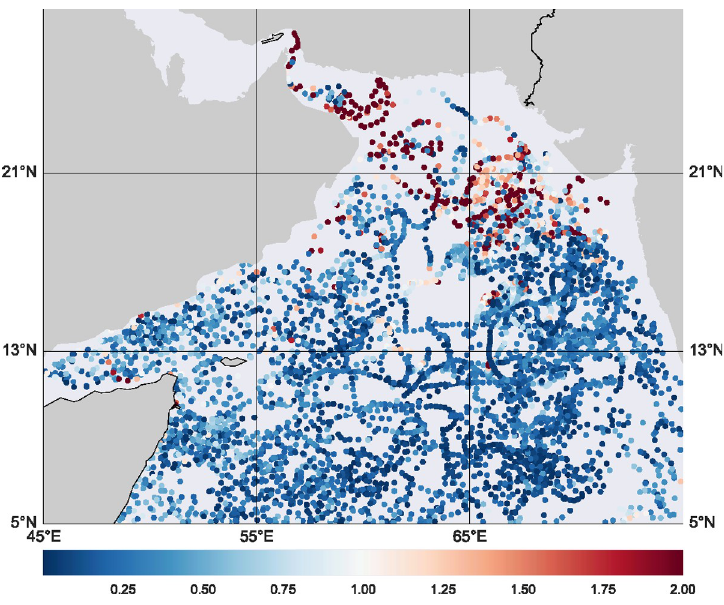
Fig 9. Spatial distribution of the vLDS prediction error for the chlorophyll a concentration ( chlor_a ).